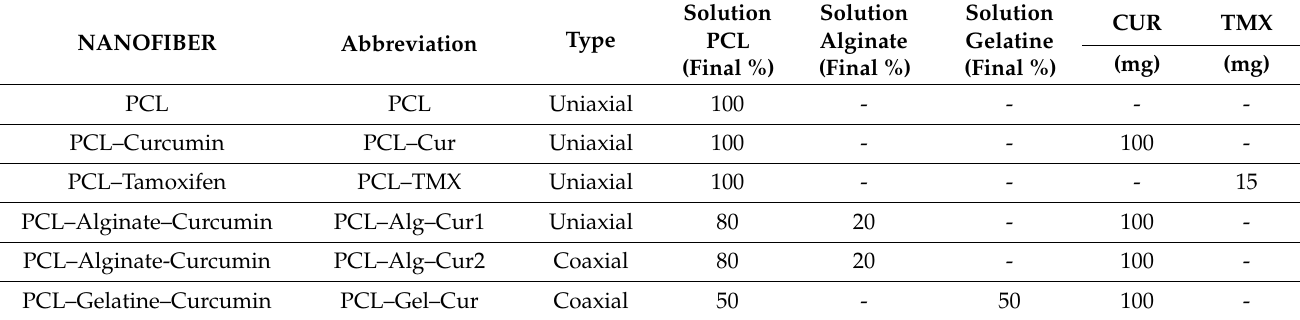
Table 1. General conditions for preparing the